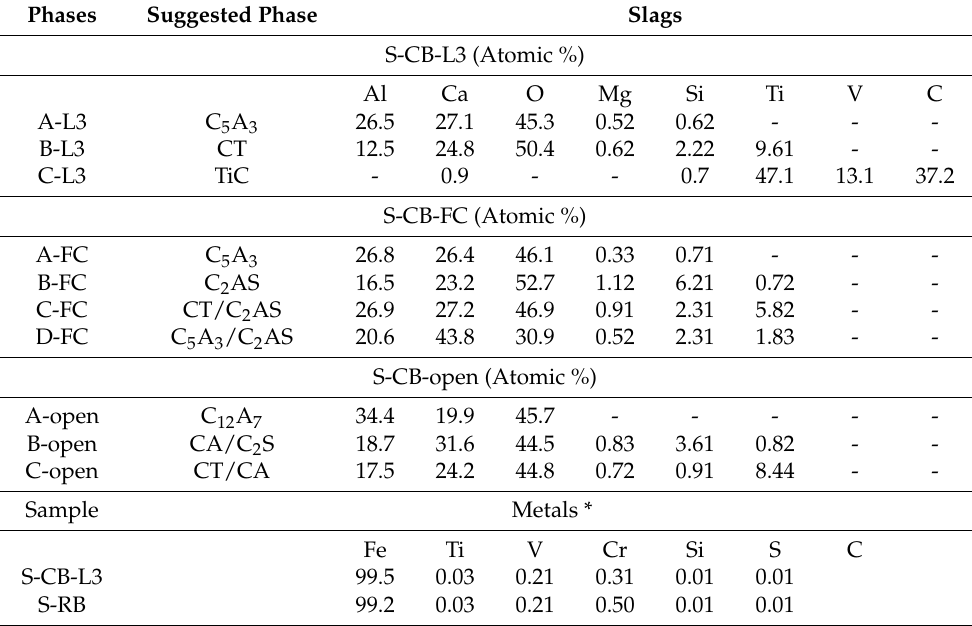
Table 4. Averaged chemical composition of slag phases for the samples S-CB-L3, S-CB-FC and S-CB-open based on EDS point analysis and metal phases based on EPMA (WDS)